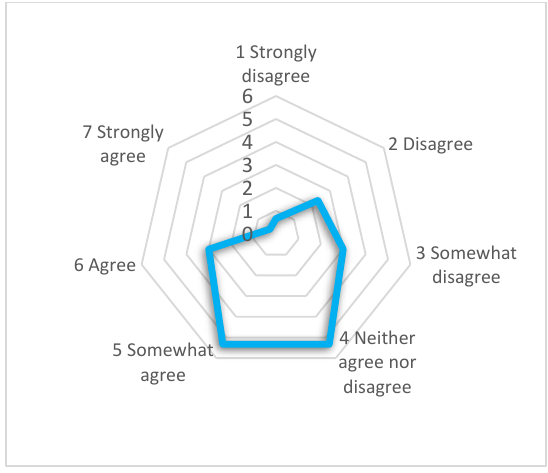
Figure 22. Overall experience assessment.